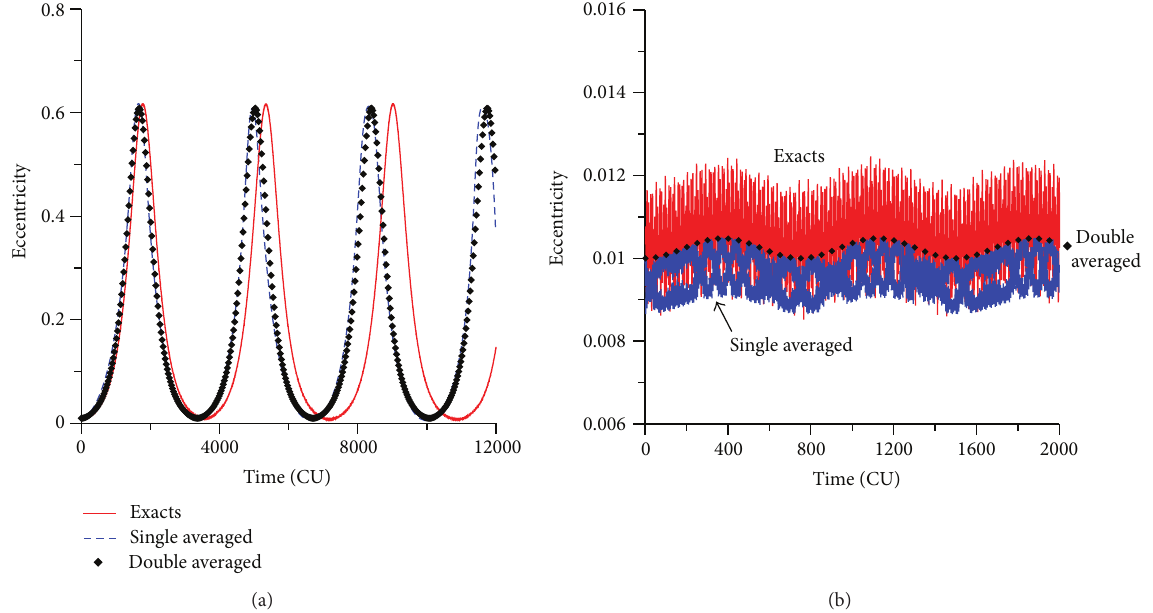
Figure 4: Evolution of the eccentricity for values of the inclination of 130 ∘ (a) and 170 ∘ (b). The initial conditions are a = 0.341 canonical units, e = 0.01, M 0 (0) = 0, 𝜔 = 0, Ω = 0.